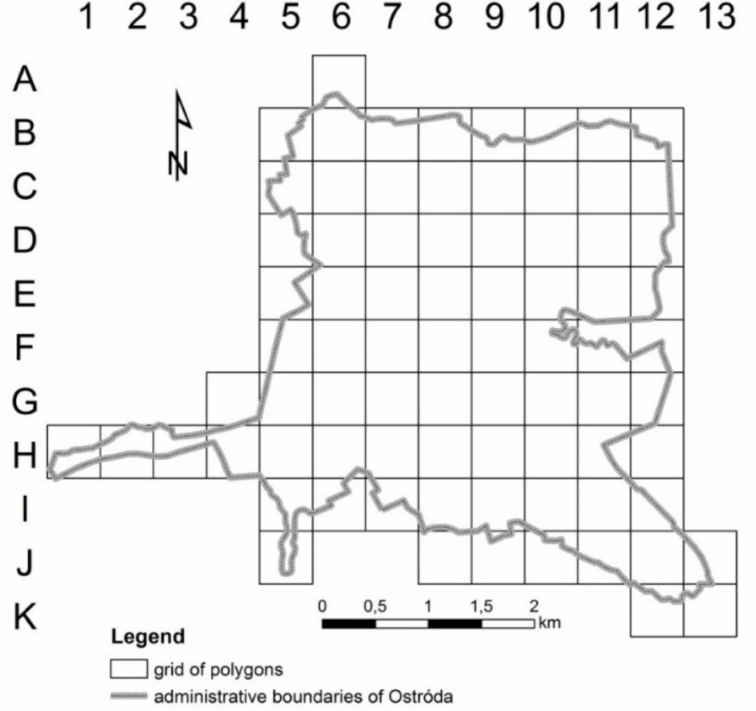
Figure 3. The planned grid of polygons within the Ostr ó da city area. Source: own